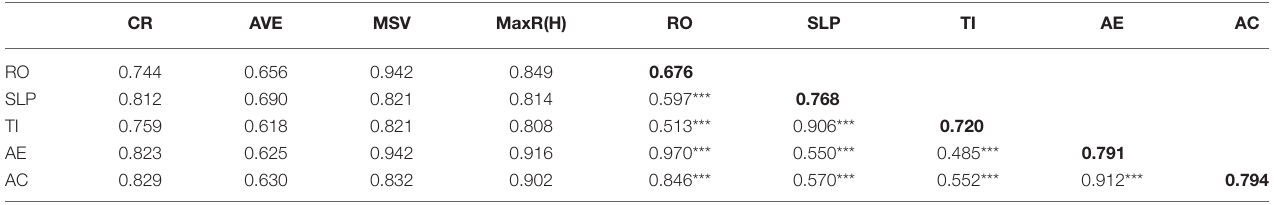
TABLE 2 | Reliability, validity, statics, and correlations.